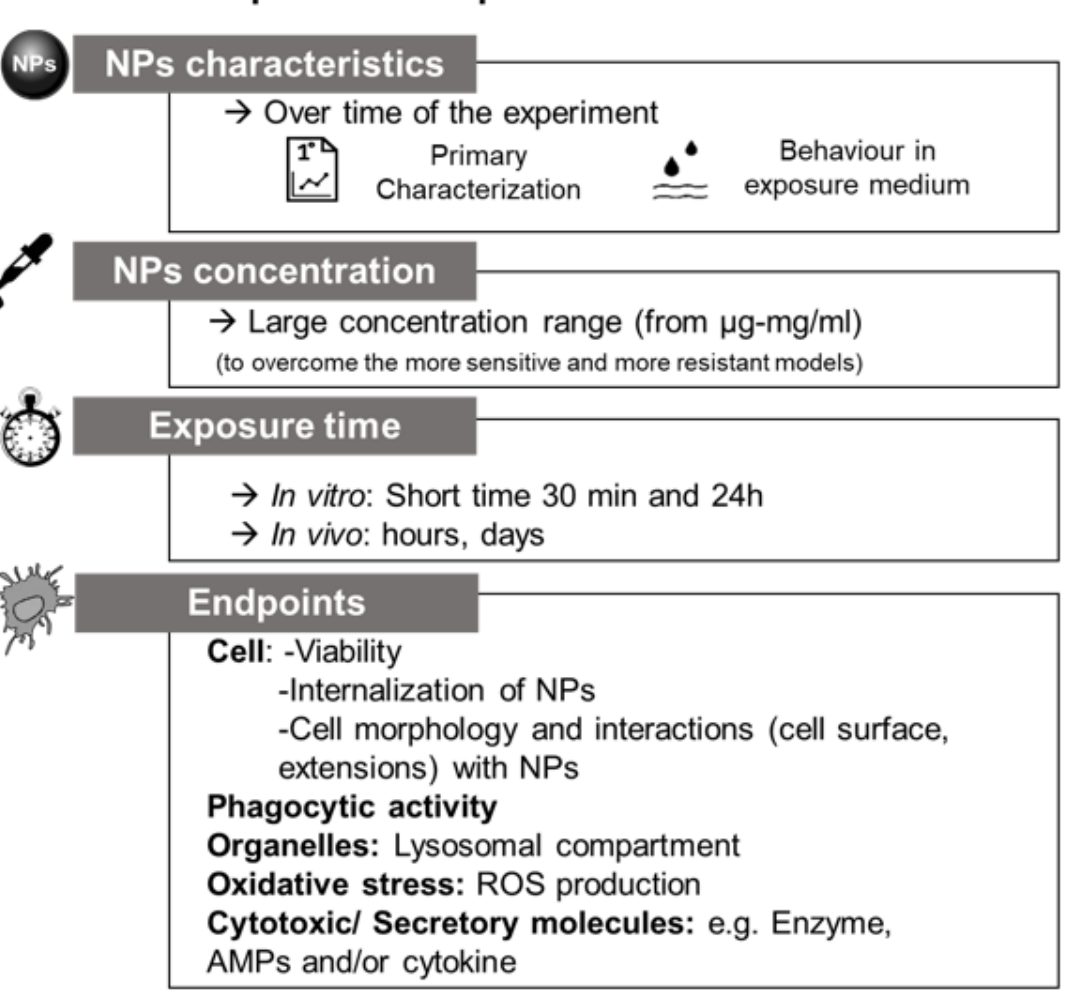
Figure 8. Proposal template for translatable NP experiments across the models of interest (plants, terrestrial and marine invertebrates, and human cells).